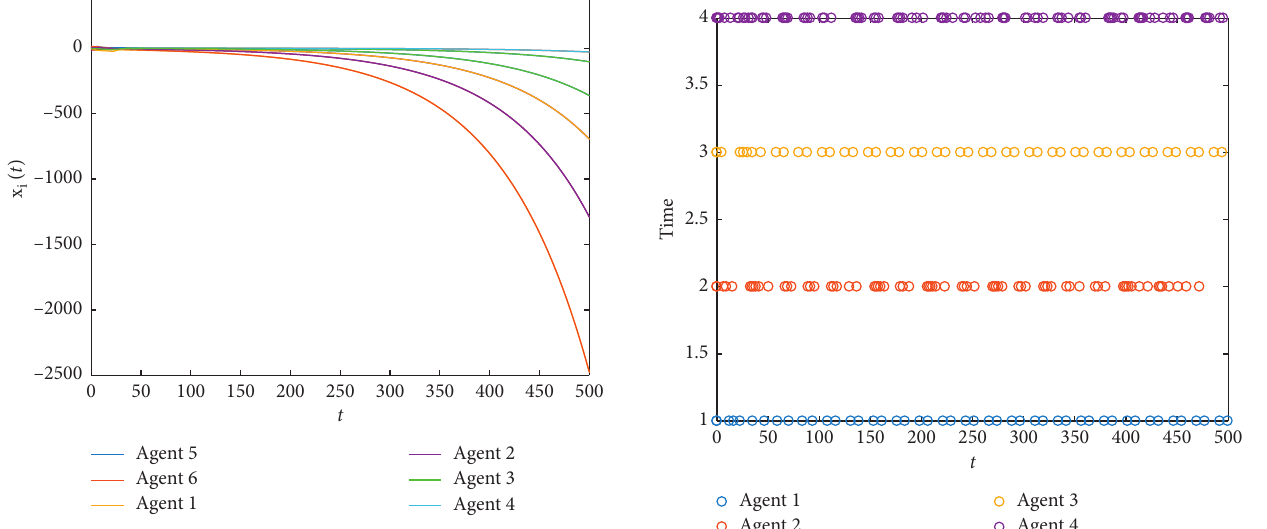
Figure 4: The states for containment control.